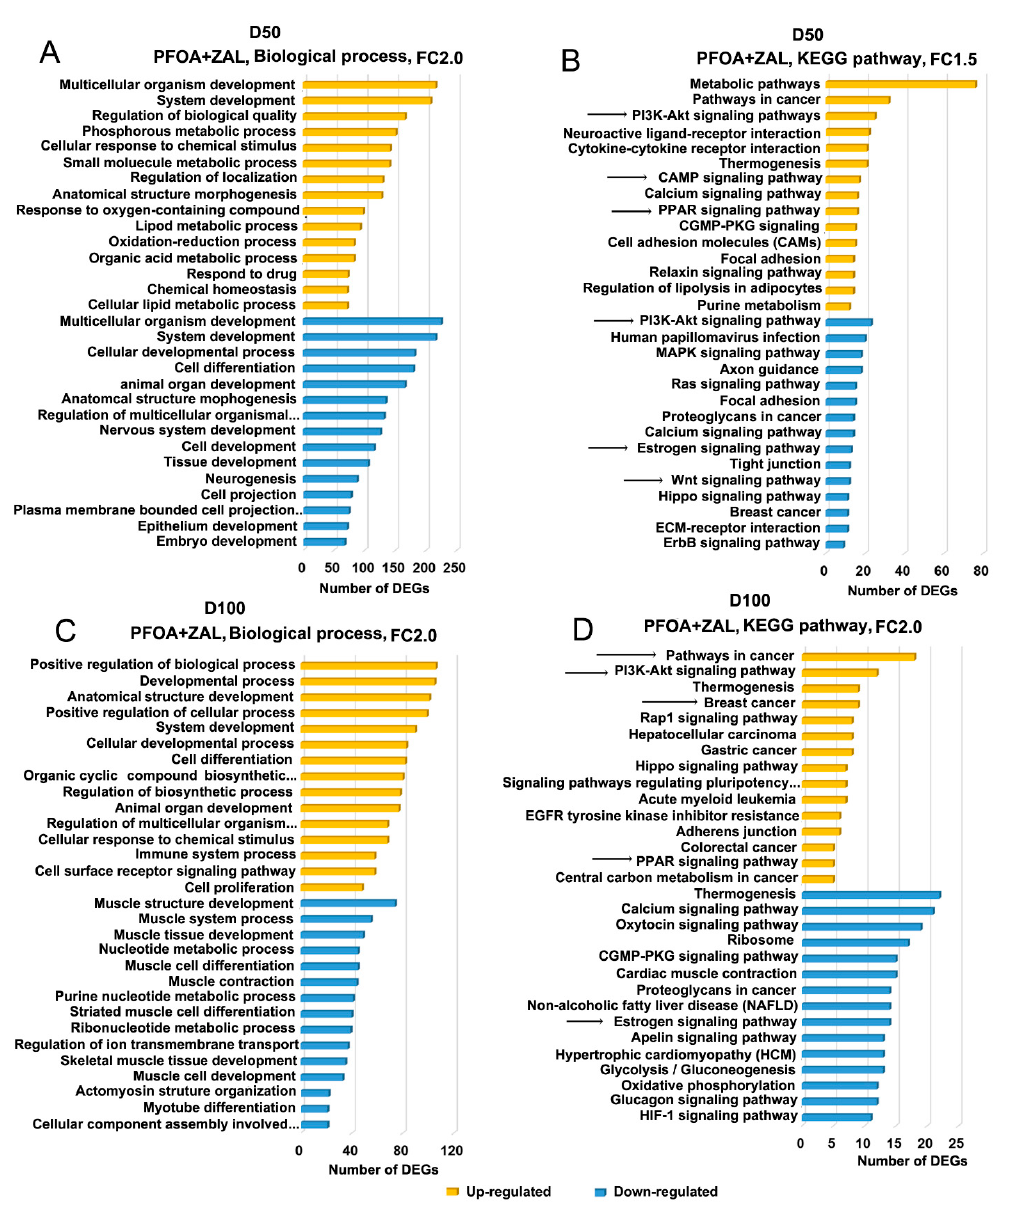
Figure 4. Biological process and KEGG pathway analysis of DEGs induced by PFOA + ZAL: ( A , C ) Bar graphs represent genes categorized according to their most prominent biological function. Gene Ontology annotations were extracted using DAVID tools and the Shiny application in R version 3.5.3. ( B , D ) Involvement of the KEGG pathway genes was determined using KEGG web tools and the Shiny application in R version 3.5.3. Arrows indicate pathways discussed in the paper.